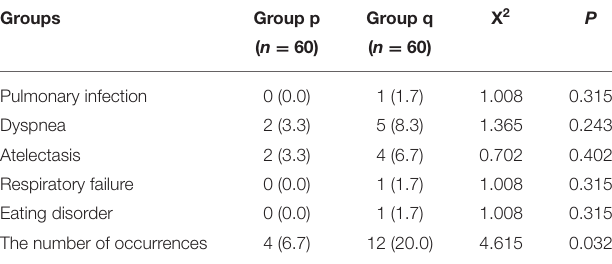
TABLE 2 | Comparison of patients’ incidence of complications [n (%)].